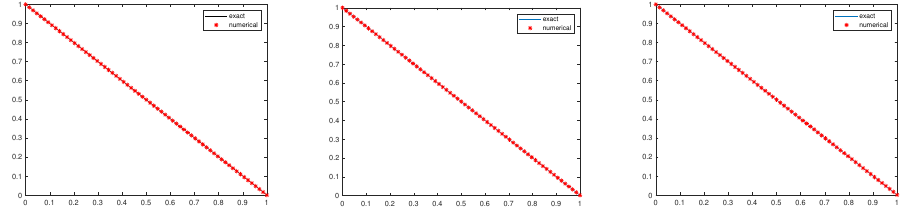
Figure 4. The exact solution and the numerical solutions (Left: σ = 0.1. Middle σ = 3. Right: σ = 5).